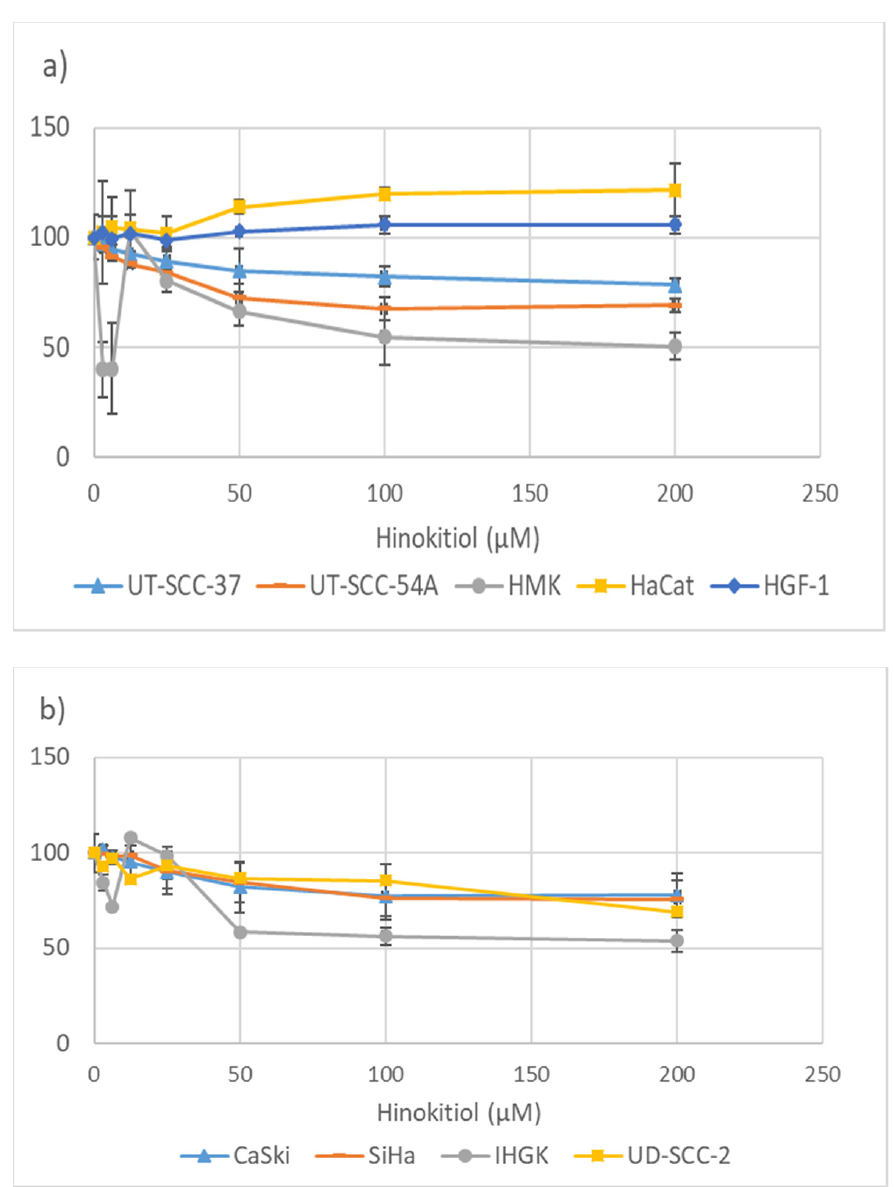
Figure 1. MTT incorporation assay. The effect of hinokitiol on cell metabolic activity was assessed with colorimetric MTT-assay. ( a ) HPV16 negative and ( b ) HPV16 positive cell lines. Cells were exposed to hinokitiol at various concentrations (0, 3.1, 6.25, 12.5, 25, 50, 100, and 200 µ M) for 24 h. After exposure, the cells were washed and incubated with MTT. The precipitated MTT was dissolved in DMSO, and the amount measured spectrophotometrically. All analyses were repeated twice and in case there was a discrepancy between the two experiment rounds the triplicate was then further done for the third time. The results are shown as % ± SD from control. MTT incorporation after hinokitiol treatments of HMK at 3.1, 6.25, and 200 µ M, of CaSki at 100 and 200 µ M, of IHGK at 50, 100, and 200 µ M and of UD-SCC-2